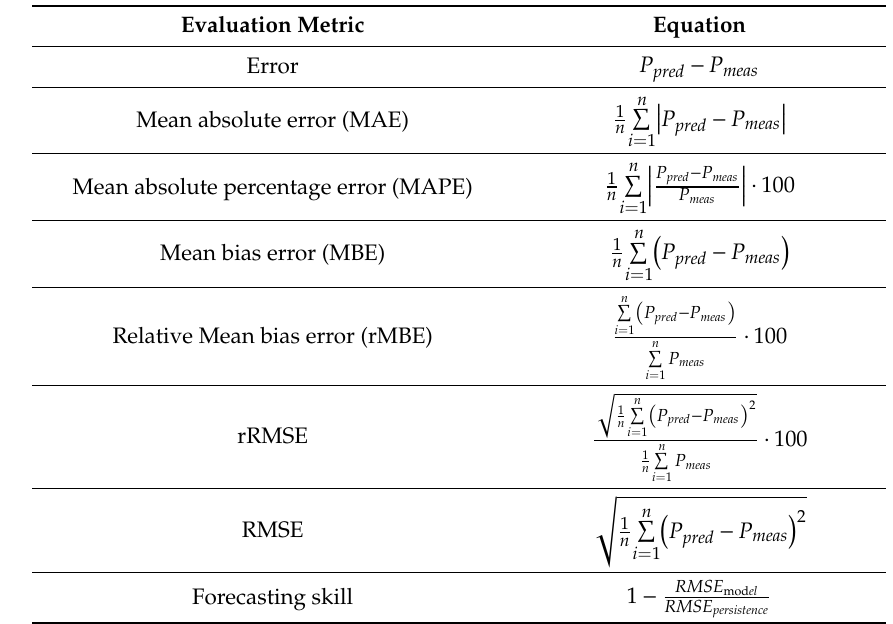
Table 2. Evaluation